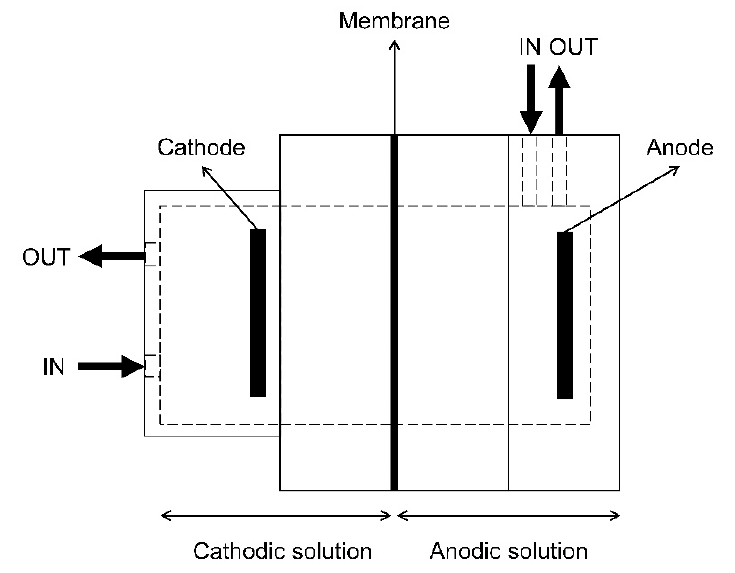
Figure 1. Two compartment electrowinning cell.